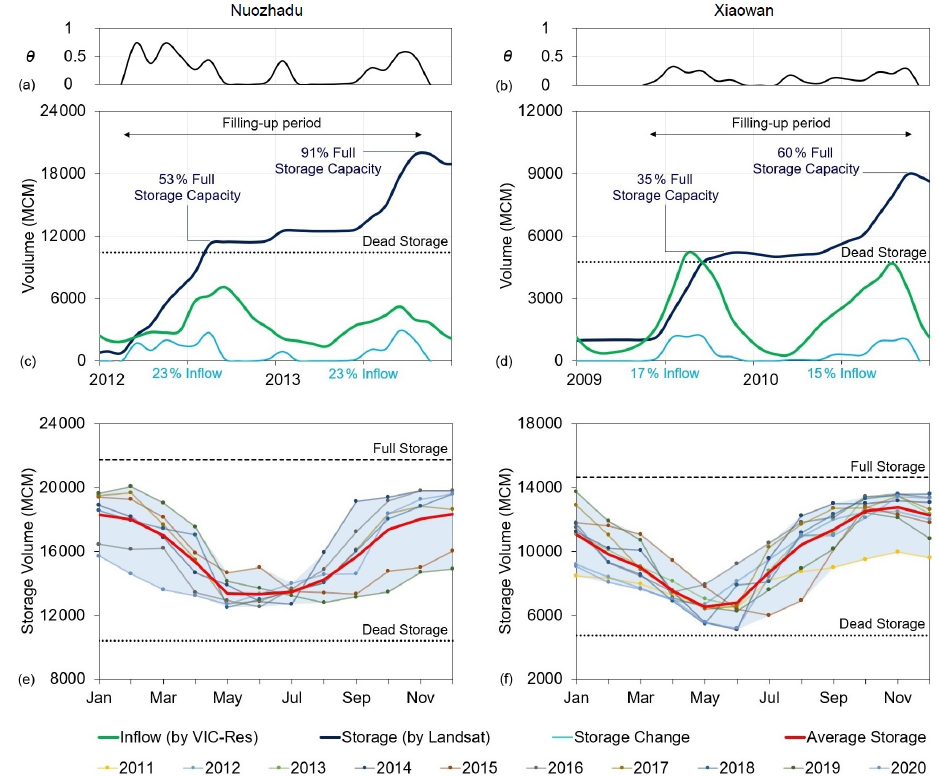
Figure 10. Filling strategies (a, b, c, d) and rule curves (e, f) of Nuozhadu (a, c, e) and Xiaowan (b, d, f) reservoirs. Panels (a) and (b) show the values of θ . In panels (c) and (d) , the storage volume (dark blue line) is derived from DEM and Landsat data, while the inflow to the reservoir (green line) is calculated with the VIC-Res hydrological model. The storage change (light blue line) is defined as the difference in storage volume between two consecutive months. In panels (e) and (f) , each line with circle makers illustrates the storage volume of a given year. The bolded red lines represent the average monthly storage volume, considered representative of the rule curves. All data visualized here have a monthly